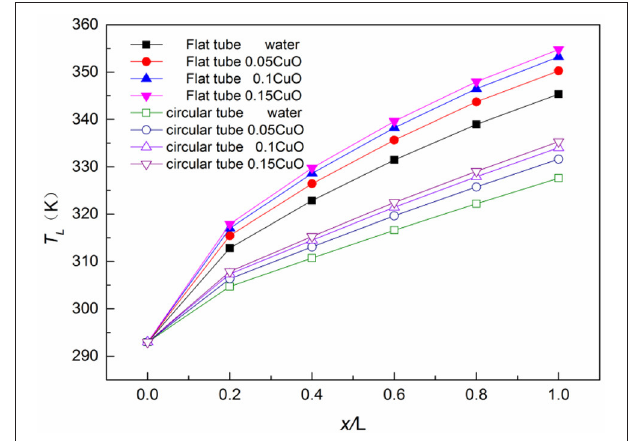
FIGURE 6 | Change of heat transfer coefficient with Reynolds number.